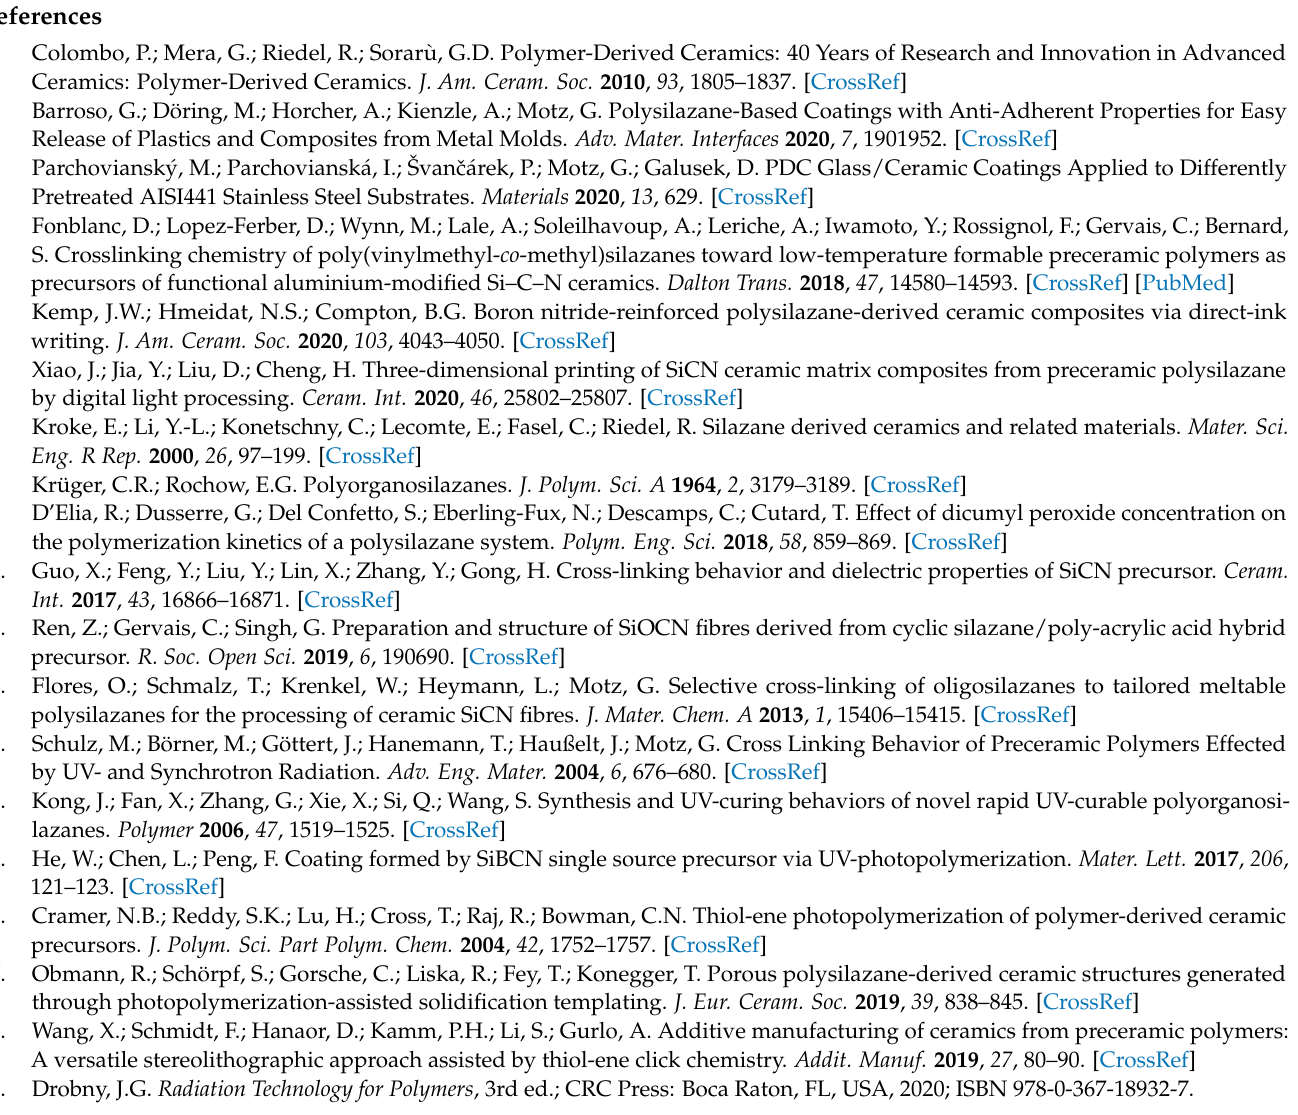
Figure A3. UV-VIS spectra of pure Durazane 1800 .